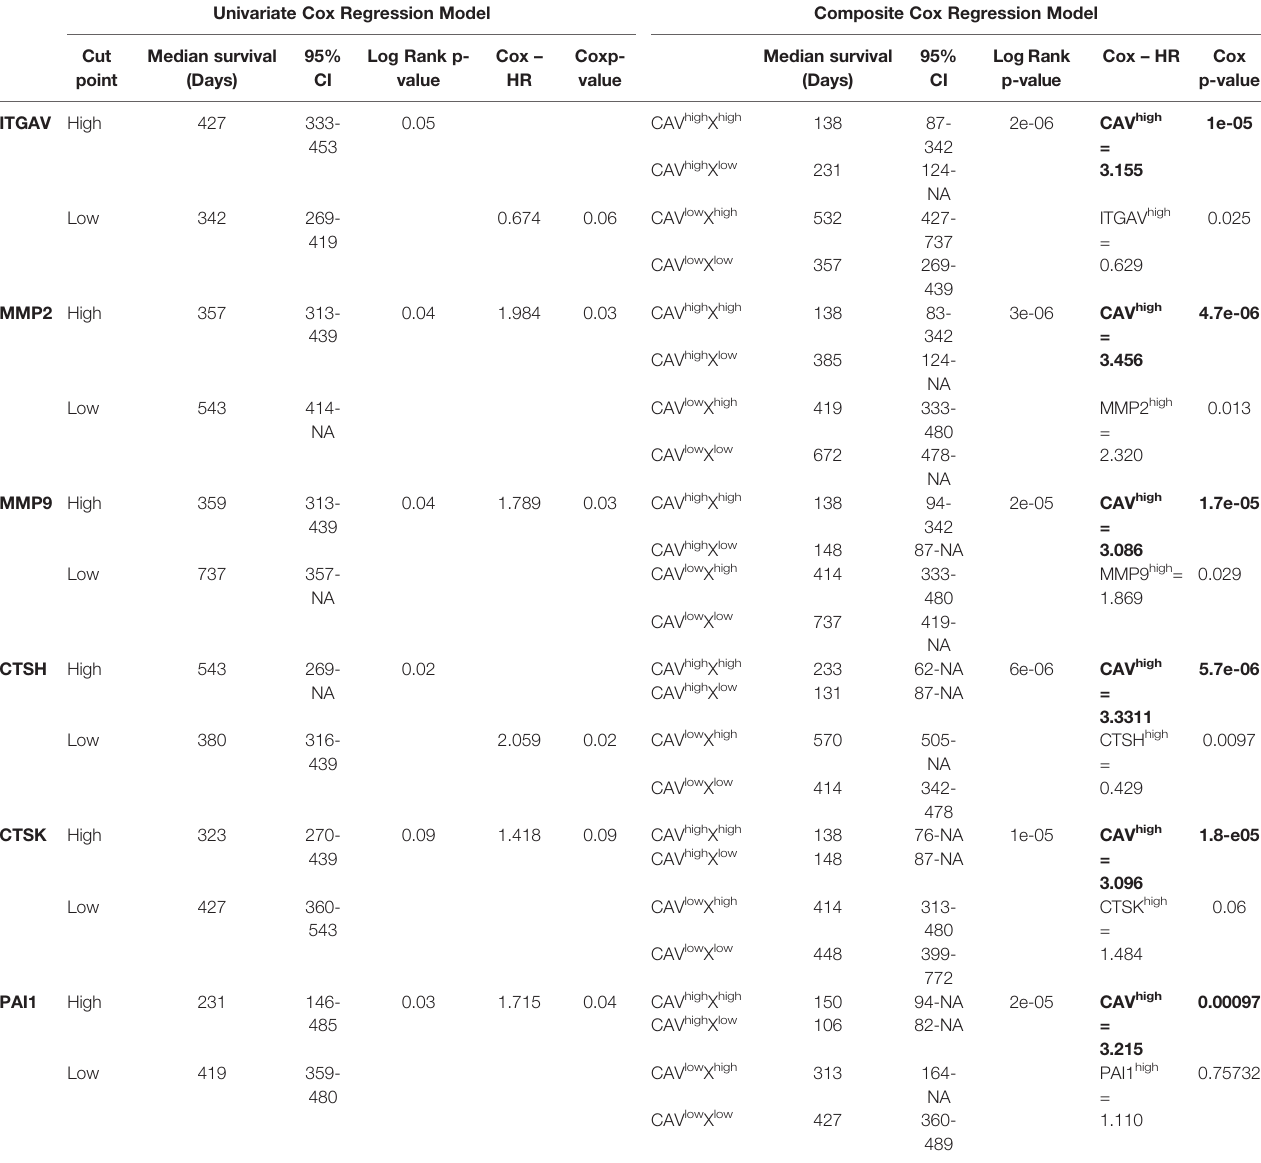
TABLE 3 | Hazard ratio for pathway molecules (MMP2, MMP9, PAI1) that when combined with Cav-1 produced a signi fi cantly greater HR than when either of these two markers were used alone, or molecules (CTSH, CTSK, ITGAV) solely when in combination with Cav-1 expression showed a signi fi cant and powerful HR. Univariate Cox Regression Model Composite Cox Regression